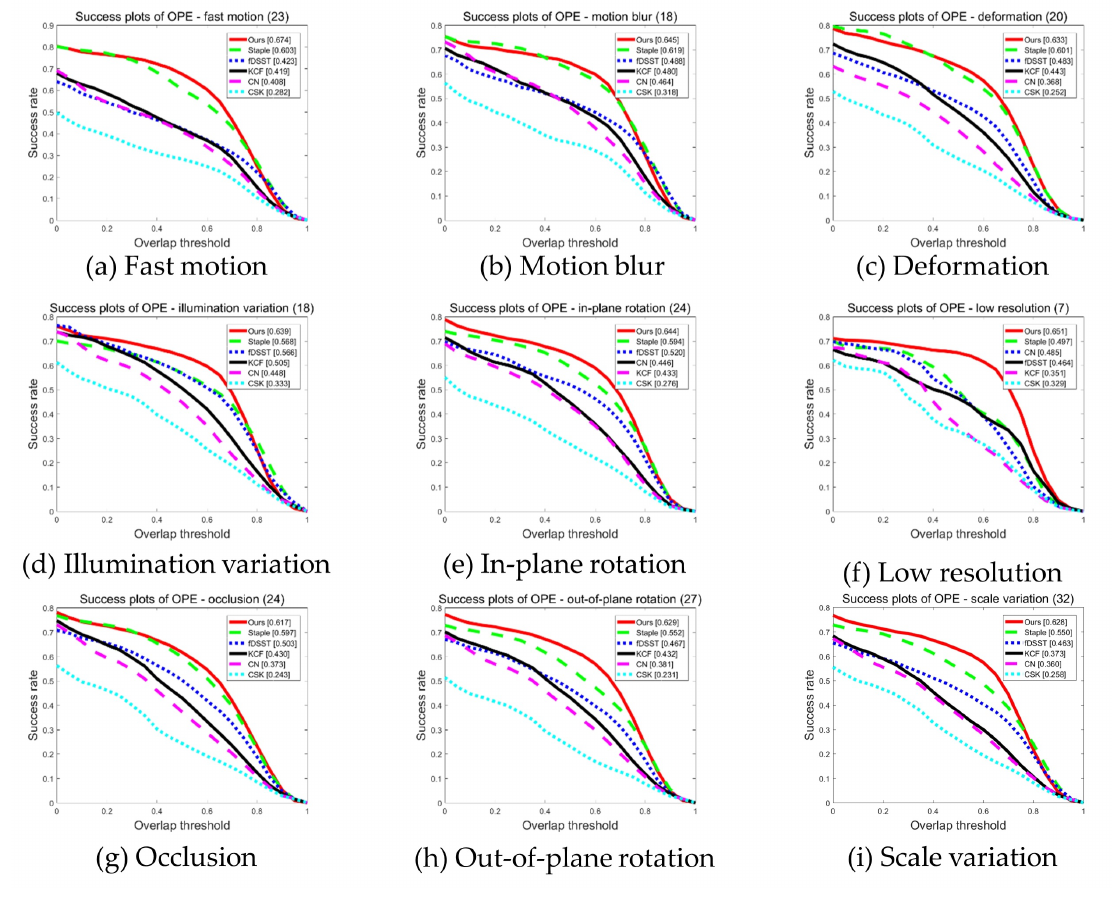
Figure 6. The success plots of OPE on 9 challenging